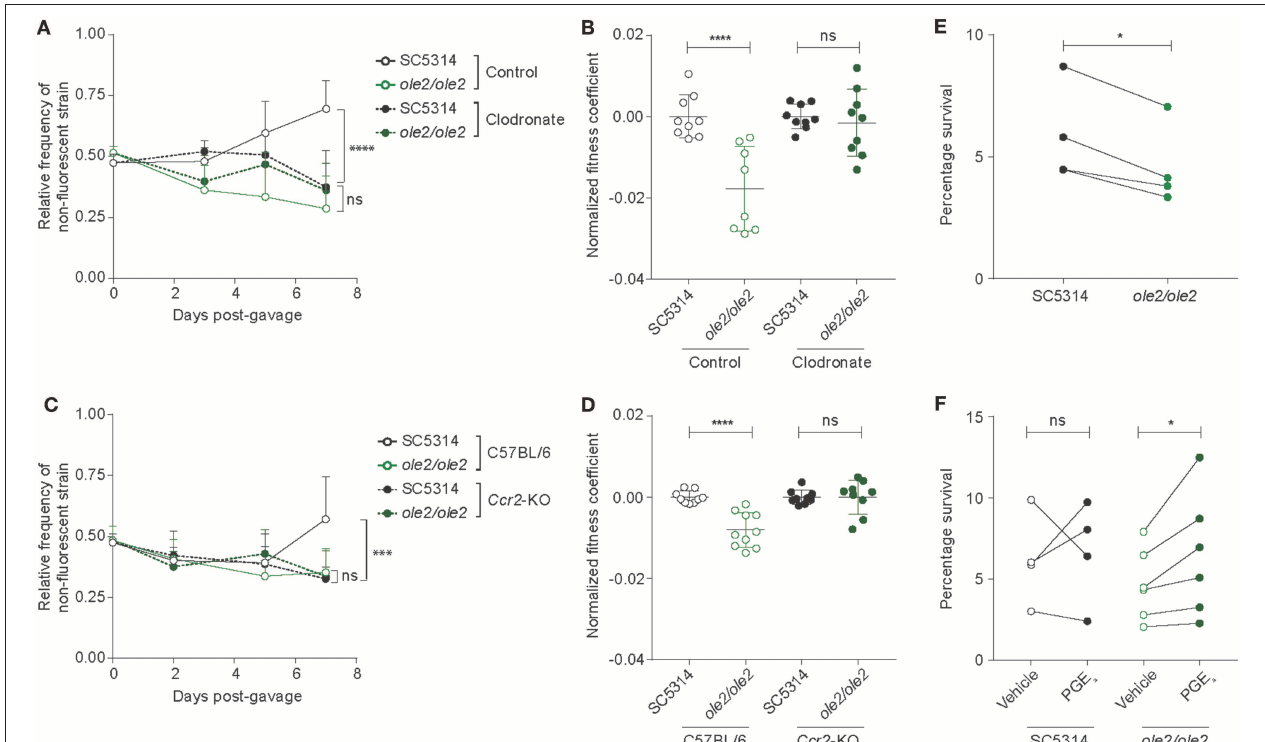
FIGURE 5 | Ablation of colonic phagocytes abrogates the fitness defect of the ole2/ole2 mutant. In vivo intestinal colonization experiments were performed as in Figure 4 . (A,B) Mice were treated with control or clodronate-containing liposomes. (C,D) WT or Ccr2 -KO mice were used for intestinal colonization. (A,C) Kinetics of the relative frequencies of the indicated fungal strains. P -values indicate comparisons of relative frequencies of the two fungal strains within each treatment (A) or genetic (C) group. (B,D) Fitness coefficients of the indicated fungal strains determined as described in Materials and Methods. Coefficients for each treatment group were normalized to the mean of the respective WT coefficients. (E) J774A.1 murine macrophages were infected with the indicated C. albicans strains for 24h and the percentage survival of each strain was determined as outlined in Materials and Methods. (F) Infection of macrophages as in (A) , but with addition of exogenous PGE 2 or vehicle to the cultures. Data pooled from 2 (A–D) or 4–6 (E,F) independent experiments. Mean ± s.d. (A–D) . n = 9–10 mice/group (A–D) . **** p < 0.0001; *** p < 0.001; * p < 0.05; ns, not significant. Two-way ANOVA with Sidak’s multiple comparisons test (A–D) ; paired student’s t -test (E,F)